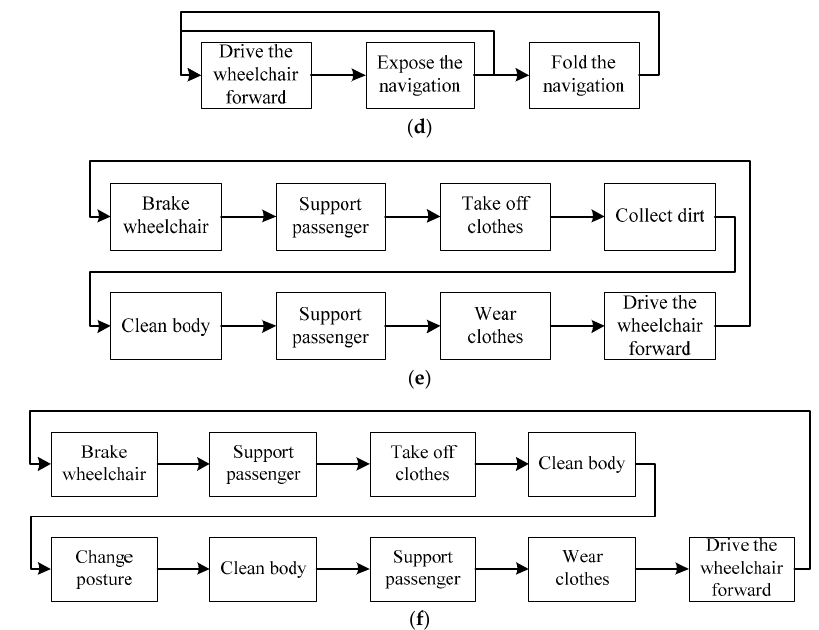
Figure 9. Function chains of the six states. ( a ) function chain G 1 , ( b ) function chain G 2 , ( c ) function chain G 3 , ( d ) function chain G 4 , ( e ) function chain G 5 , ( f ) function chain G 6 .